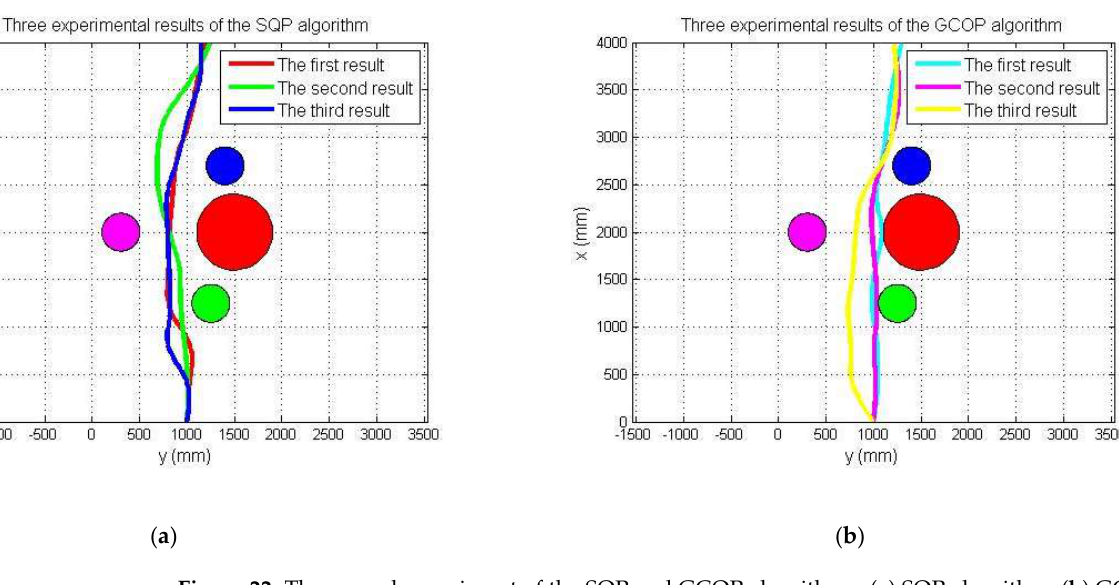
Figure 22. The second experiment of the SQP and GCOP algorithms. ( a ) SOP algorithm; ( b ) GCOP algorithm (the red ball represents an obstacle with a diameter = 500 mm and other balls represents an obstacle with a diameter = 200 mm).